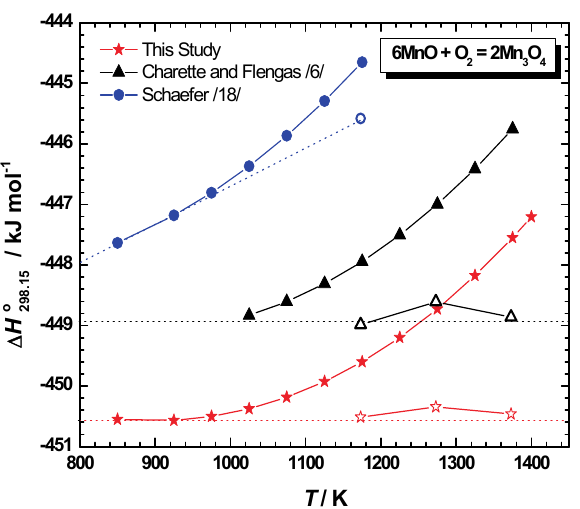
Table 2. The standard Gibbs energy change for the reaction (12), 6 MnO C O 2 ! 2 Mn 3 O 4 , computed from oxygen ity of MnO.